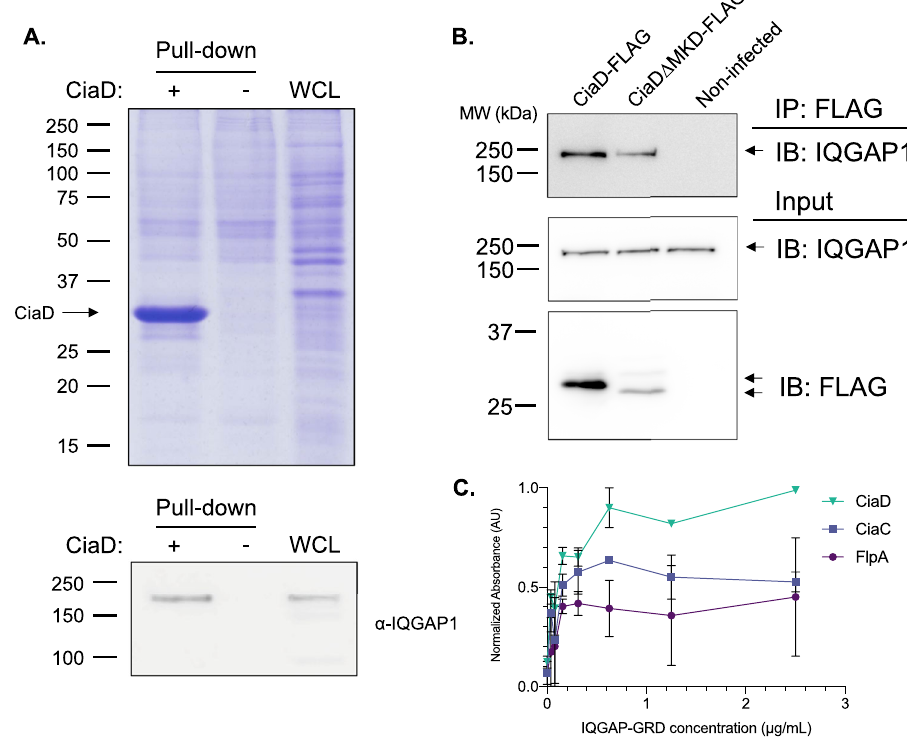
Fig. 2 CiaD interacts with IQGAP1. A , upper Recombinant His6-CiaD was produced and puri fi ed from E. coli and then mixed with a whole-cell lysate (WCL) prepared from INT 407 cells. The His6-CiaD was then pulled down using Talon af fi nity resin. The protein mixtures were separated by SDS-PAGE and stained with Coomassie Brilliant Blue R-250, where recombinant CiaD is clearly visible. A , lower The sample was tested for the presence of IQGAP1 by immunoblot, and it was observed that IQGAP1 pulls down in the presence of CiaD ( + ) but not in the absence of CiaD ( − ). IQGAP1 is also present in the INT 407 WCL used for the pull-down input. Molecular weights are indicated in kDa. B Anti-FLAG immunoprecipitations (IPs) were performed with INT 407 cells that were infected with a C. jejuni F38011 Δ ciaD mutant harboring either the CiaD-FLAG (CiaD) plasmid or the CiaD Δ MKD-FLAG (CiaD Δ MKD) plasmid. These constructs express the CiaD proteins from a constitutive promoter. The CiaD Δ MKD-FLAG construct is missing the Mitogen-activated protein kinase docking motif (MKD) within CiaD. IPs were probed with an antibody for IQGAP1. It was found that CiaD-FLAG was delivered by C. jejuni and associates with IQGAP1. The inputs for the FLAG IPs were also probed for IQGAP1 and FLAG to determine initial protein abundance. Arrows indicate expected molecular weight for each blot. Molecular weights are indicated in kDa. C An ELISA was performed to determine the binding between the recombinant GRD domain from IQGAP1 (IQGAP1-GRD), and recombinant C. jejuni proteins CiaD, CiaC and FlpA ( n = 2 independent samples). Binding between the C. jejuni proteins was assessed against increasing concentrations of IQGAP1-GRD. CiaD showed the greatest binding potential. Values are shown as normalized absorbance that has been scaled from zero (minimum assay value) to one (maximum assay value). Error bars represent the standard error of the